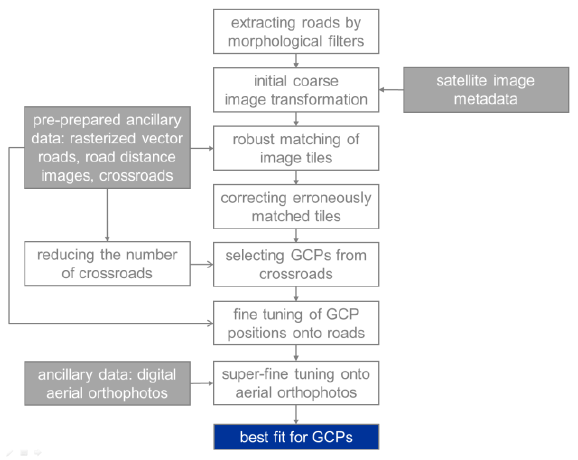
Figure 6. Workflow of the Automatic GCP Extraction module, improved for very high resolution WorldView-2 images.